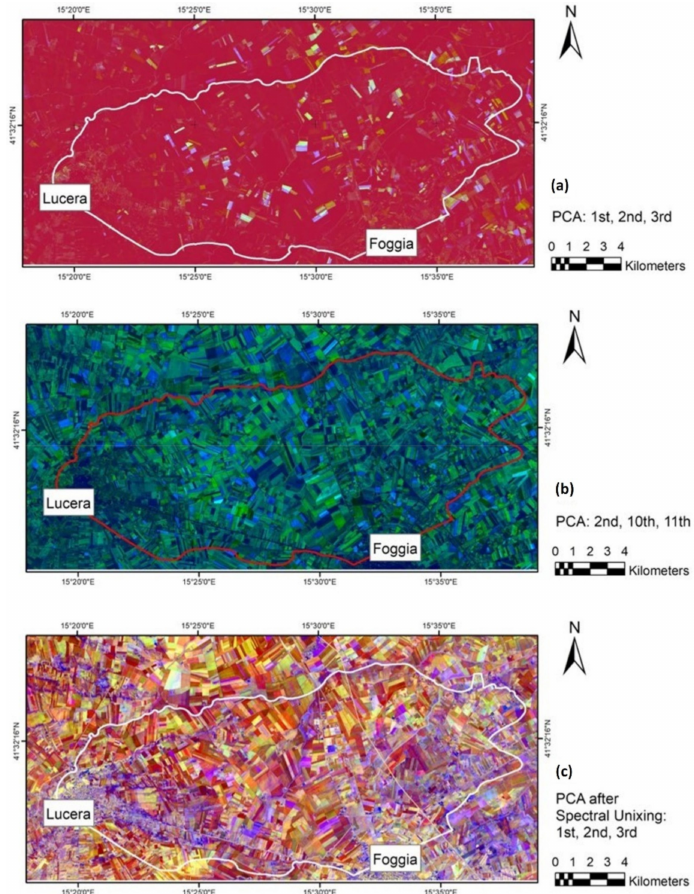
Figure 8. RGB produced using Principal Component Analysis (PCAs) components: ( a ) PCA obtained from the first process with R: 1st component, G: 2nd component, B: 3rd component; ( b ) PCA obtained from the first process with R: 2nd component, G: 10th component, B: 11th component; ( c ) PCA obtained from the second method with R: 1st component, G: 2nd component, B: 3rd